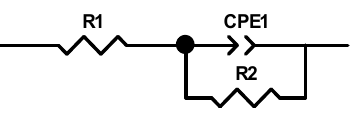
Figure 9. Electrochemical impedance curves of the as-received and oxygen hardened alloy in Ringer’s solution. ( a ) Bode impedance and phase angle plot, ( b ) Nyquist impedance plot.